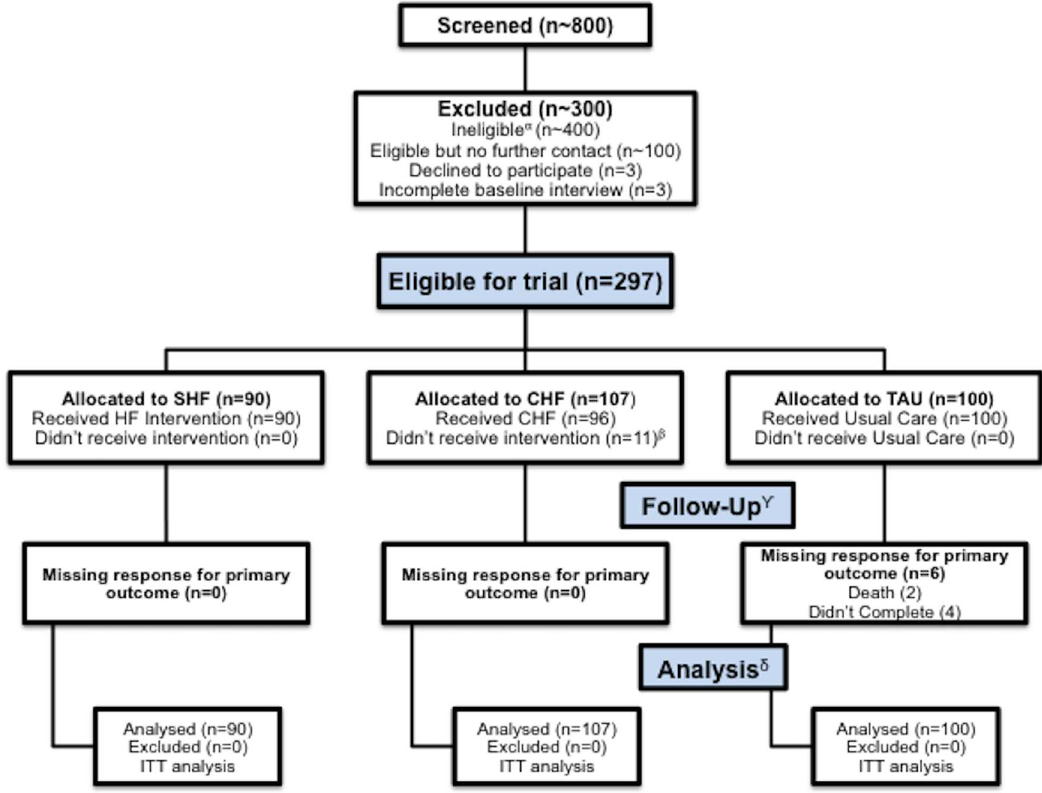
Fig 1. Participant flow through screening, assessment,allocation to study arm, completion of follow-up visits and inclusion in the